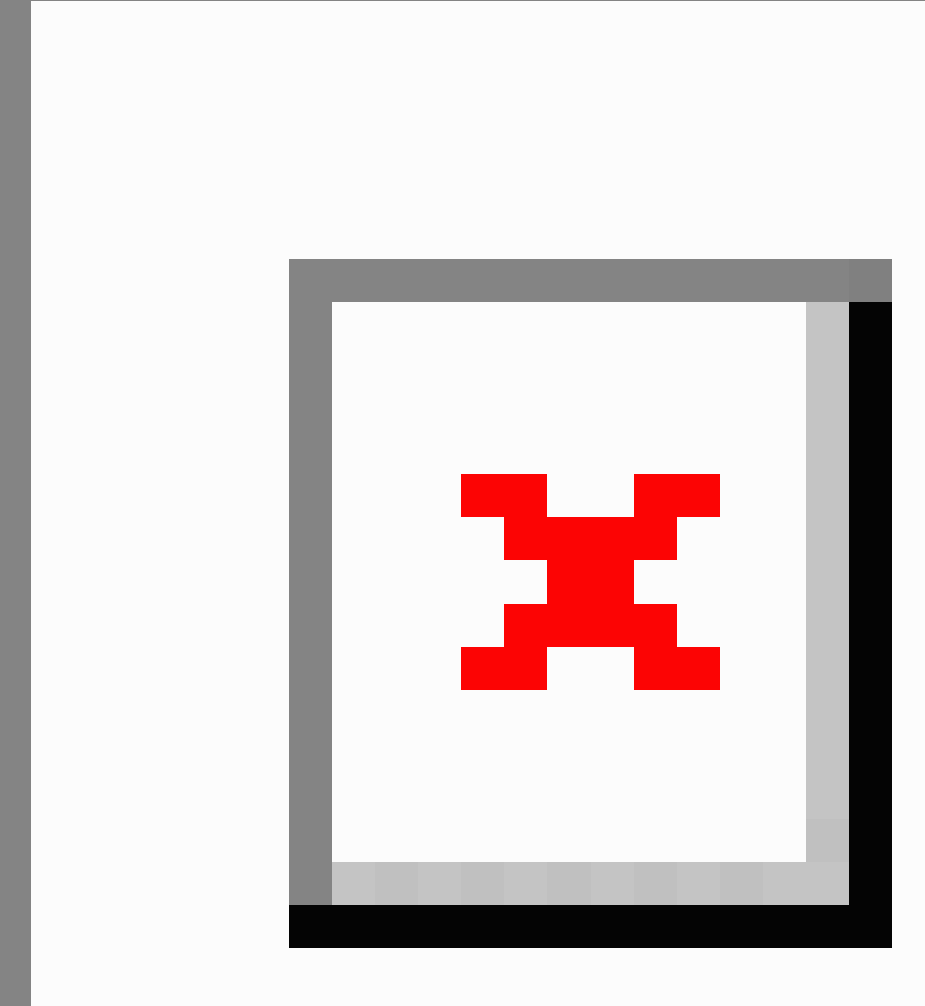
Figure 2. User story box of the